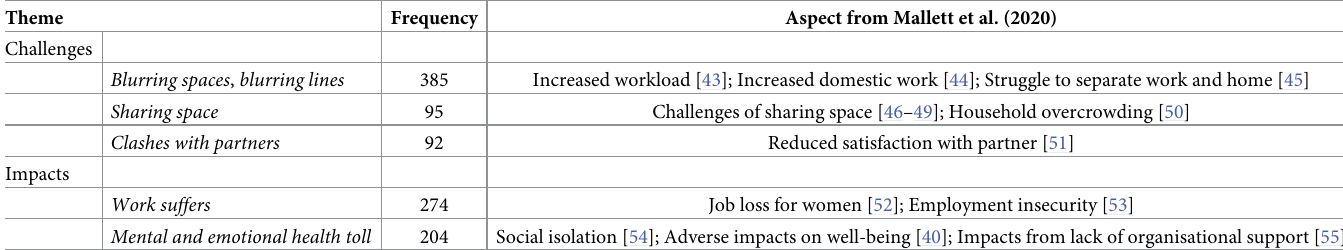
Table 1. Emergent themes and their connection to gendered aspects of homebased working from Mallett et al.